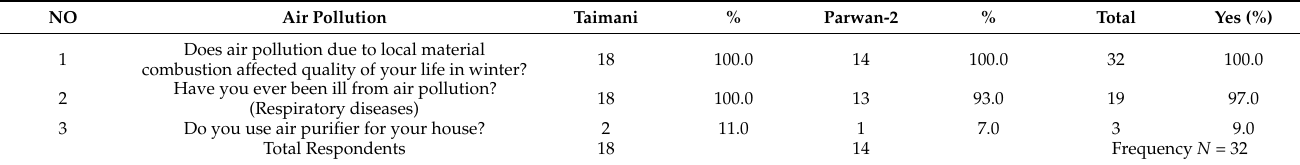
Table 5. Air Pollution